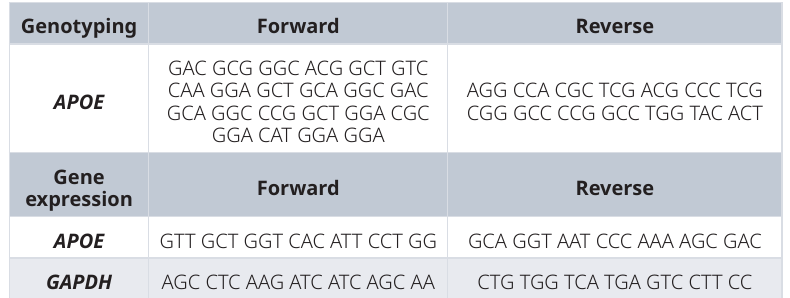
Table 2. C values of APOE were normalised to that of T GAPDH , and relative expression of APOE across samples were quantified using the 2 - ΔΔ Ct method where D7 sample was used as a reference for each differentiation lineage. Raw dataset is available as an underlying data via Figshare (doi: 10.6084/ m9.figshare.12136944).